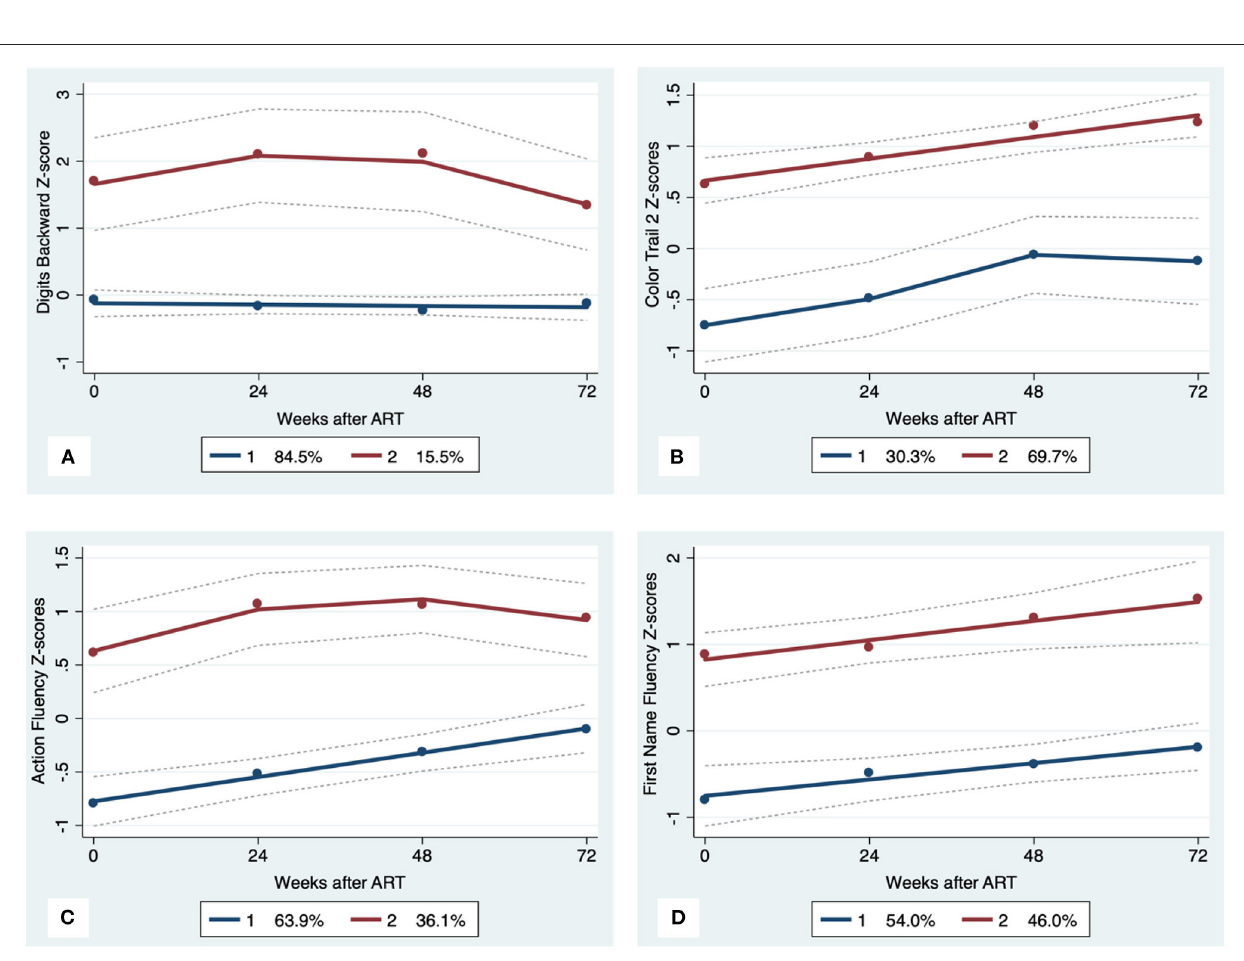
FIGURE 2 | Executive Function trajectory subgroups, Solid lines represent estimated trajectories, dot symbols are observed group means at each assessment wave, and dashed lines are 95% pointwise confidence intervals on the estimated trajectories. (A) WAIS-III Digits Backward; (B) Color Trails 2; (C) Action Fluency; and (D) First Name